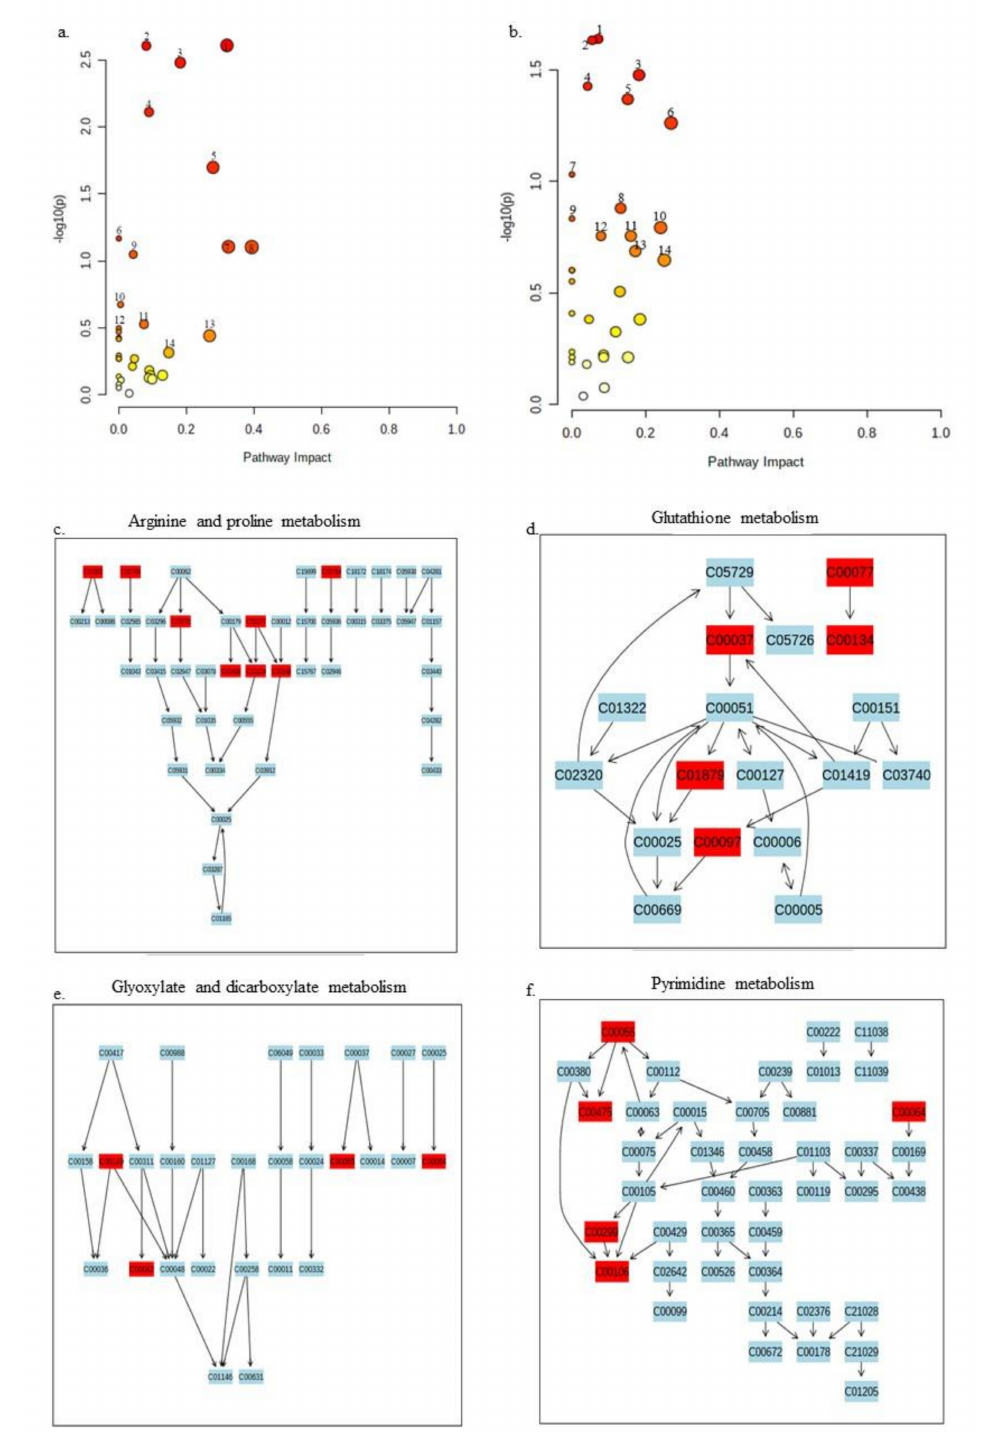
Figure 4. Simulated pathway analyses of significant metabolites in this study against pathways of Pseudomonas putida KT2440. The strength of the impact of the analyzed metabolites is indicated in red and yellow. A deep red color indicates that many metabolites with significant changes as a result of carvacrol application are found in the pathway, and this decreases to a different shade of red, yellow, and white (no metabolite in the pathway). The pathways that have more than one annotated metabolite in this study are labeled from 1–14 in both panels. Panel ( a ) shows pathways of positive ion mode metabolites. 1 = arginine and proline metabolism, 2 = glutathione metabolism, 3 = aminoacyl tRNA biosynthesis, 4 = pyrimidine metabolism, 5 = glycine, serine, threonine metabolism, 6 = cyanoamino metabolism, 7 = arginine